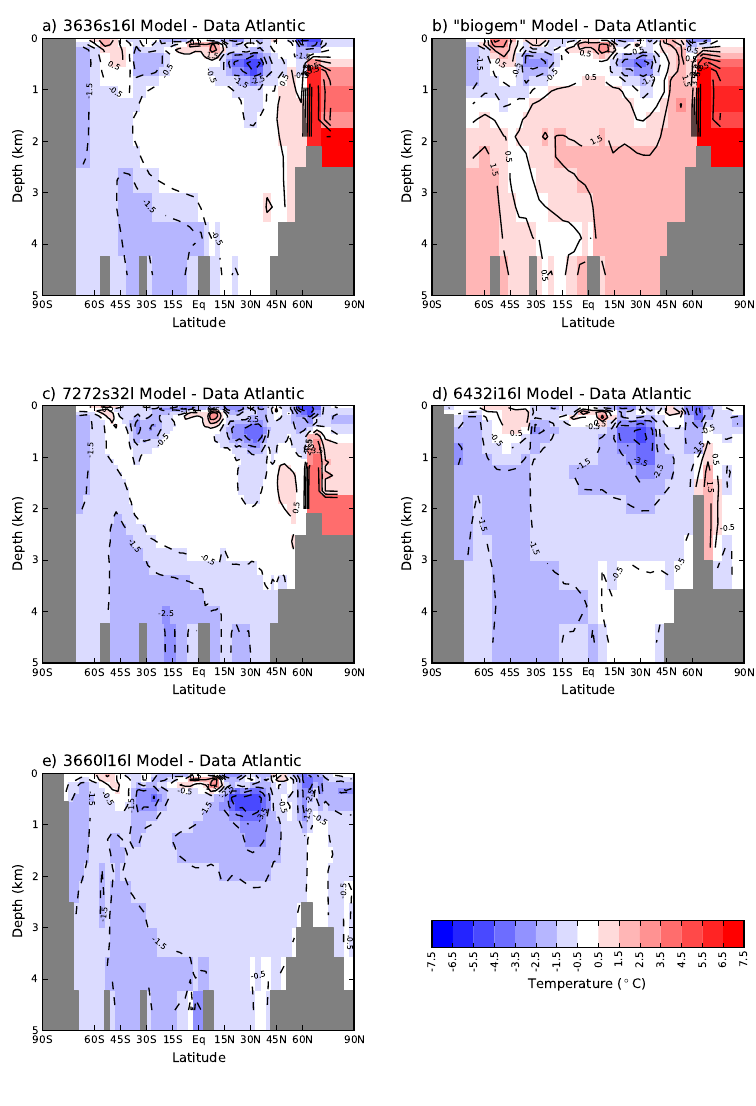
Fig. 13. Annual-mean “model minus observation” differences of zonally-averaged temperature in the Atlantic, for the five experiments. Observations have been interpolated and extrapolated (see text) from the Locarnini et al. (2006)